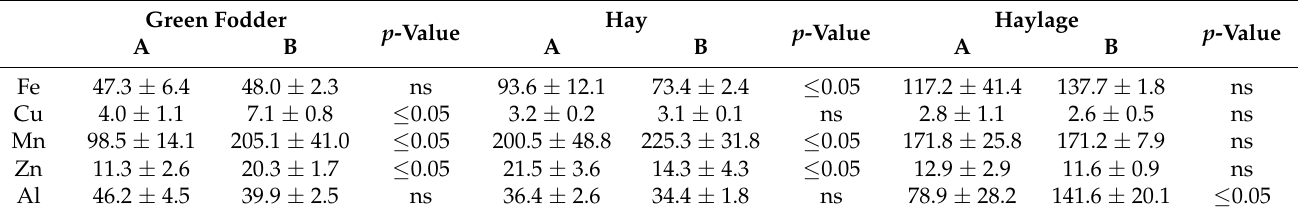
Table 1. Content of selected trace elements in feeds used in horse nutrition, mean ± SD (mg · kg − 1 DM). Green Fodder